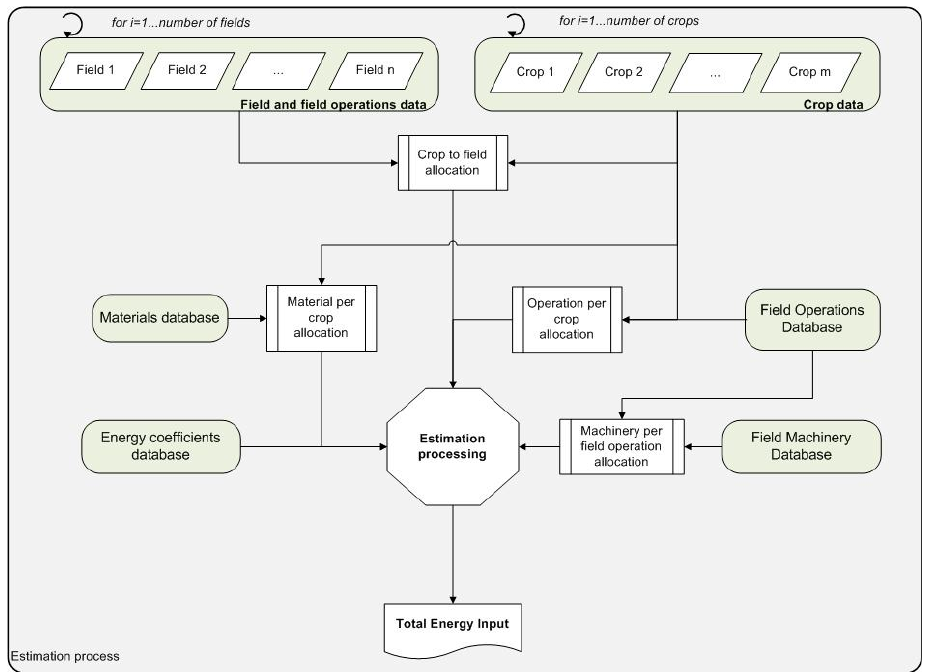
Figure 2. Core design of the estimation process.